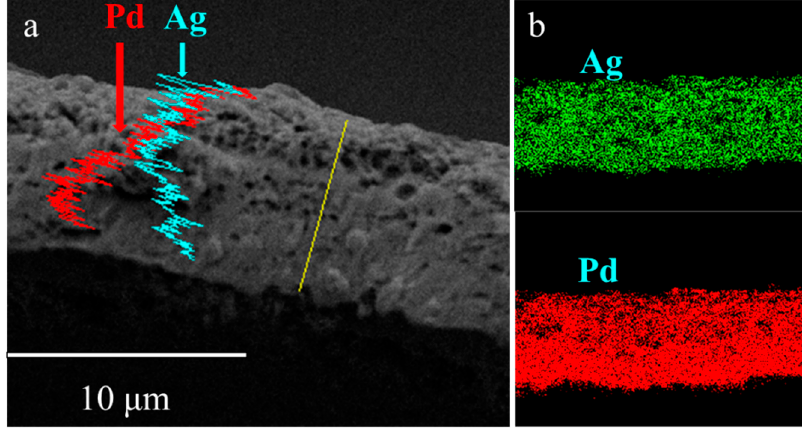
Figure 5. Cross-sectional X-ray spectroscopy (EDS) analysis of ( a ) PA-2 and ( b ) PA-1.